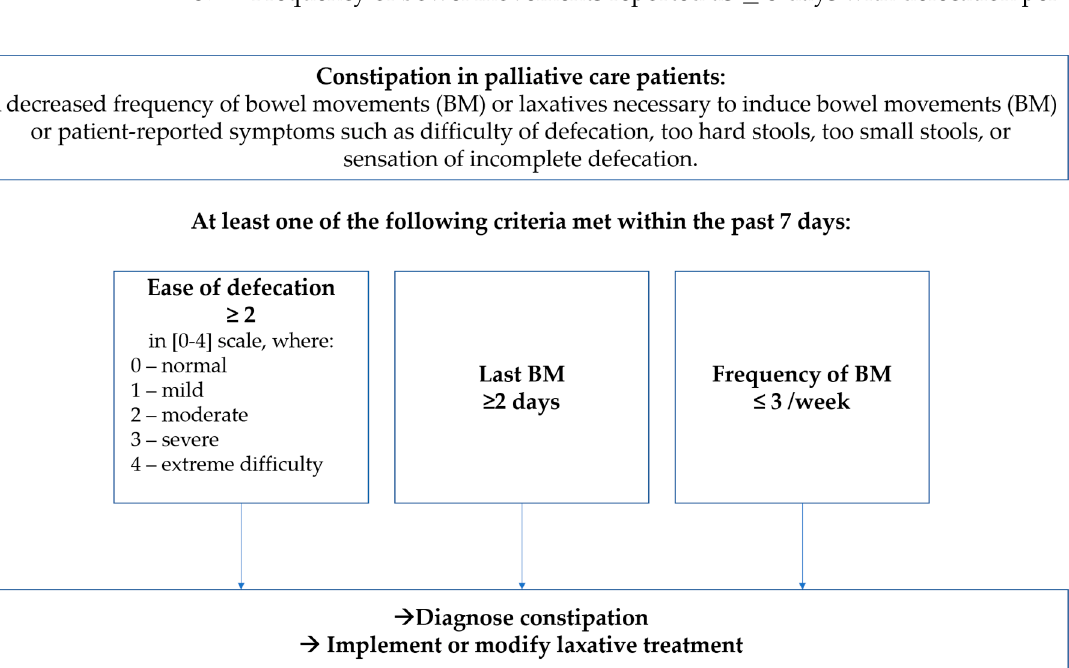
2. Last bowel movements present ≥ 2 days before. 3. Frequency of bowel movements reported as ≤ 3 days with defecation per week.